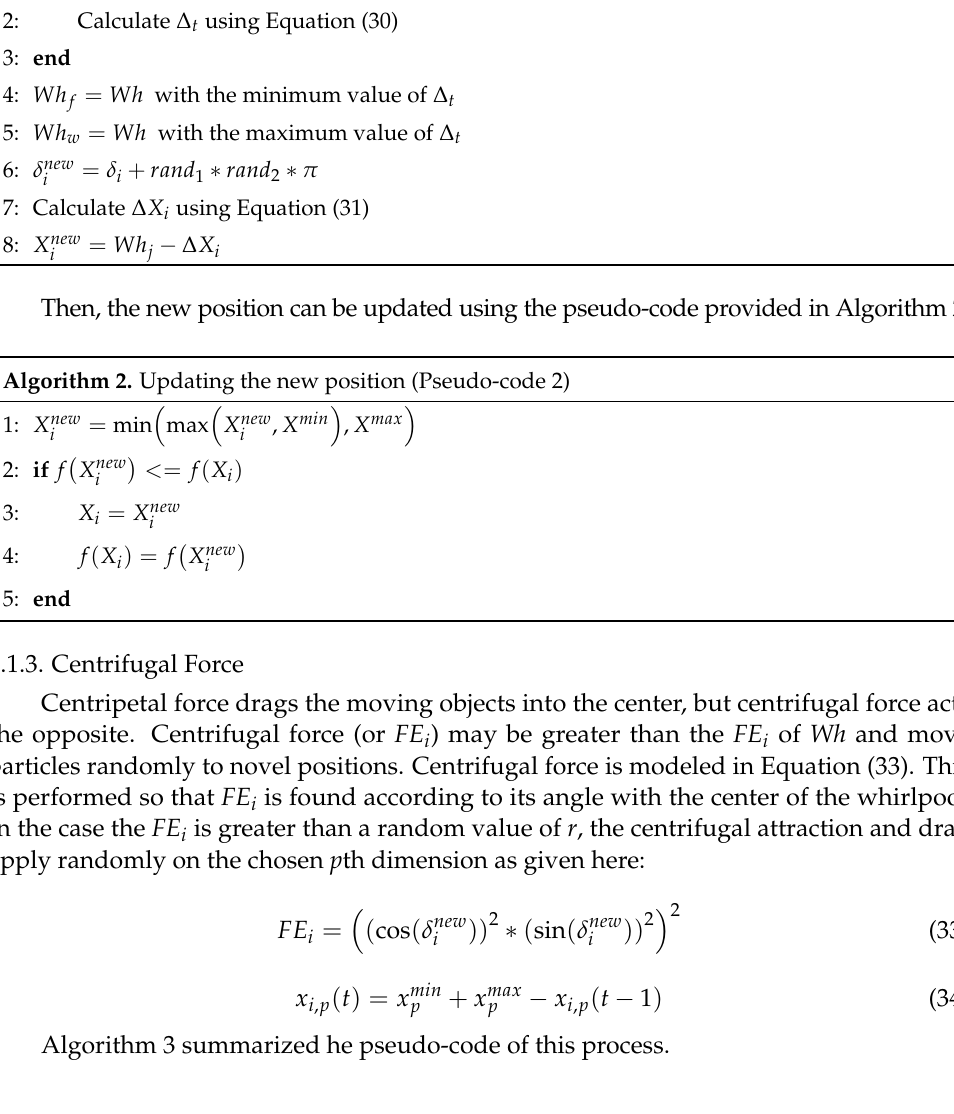
Algorithm 3 summarized he pseudo-code of this